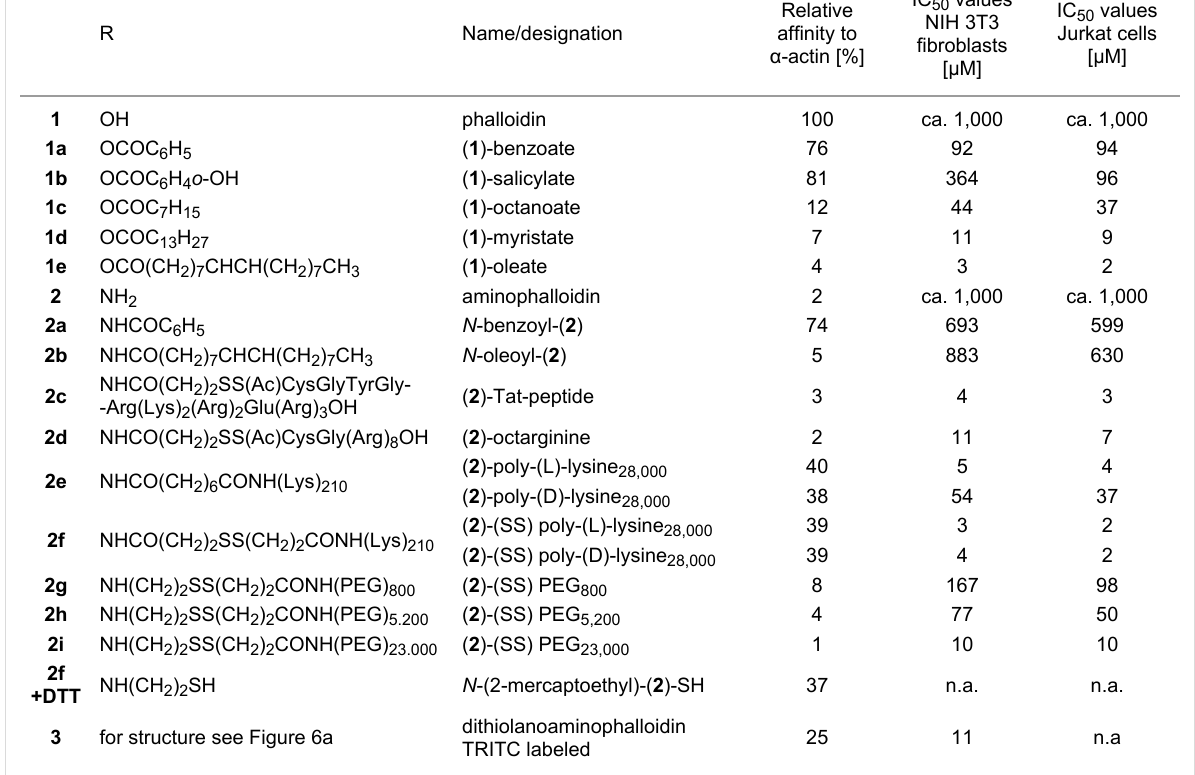
Table 1: Structures of phalloidin derivatives, their relative affinity values for α -actin as compared to phalloidin and their IC 50 values of cell growth inhi- bition after incubation for 72 h as determined by MTT cell proliferation assay (n.a.: not assayed).